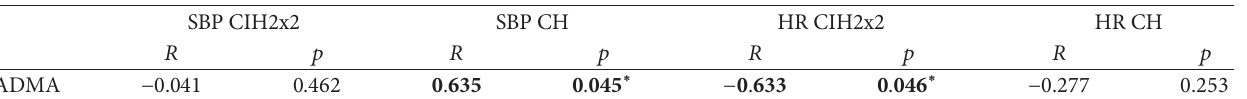
Table 2: Correlation of ADMA, systolic blood pressure (SBP), and heart rate (HR) of rats exposed 30 days to chronic intermittent hypoxia (CIH2x2) and chronic hypoxia (CH); 𝑝 = 𝑝 value; 𝑅 = Pearson correlation coefficient; ∗ one-tailed significance level = 0.05.